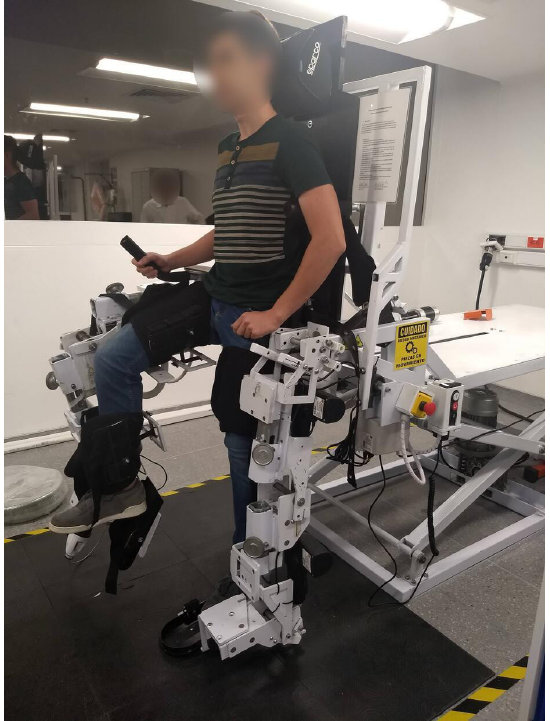
Figure 2. Nukawa , the